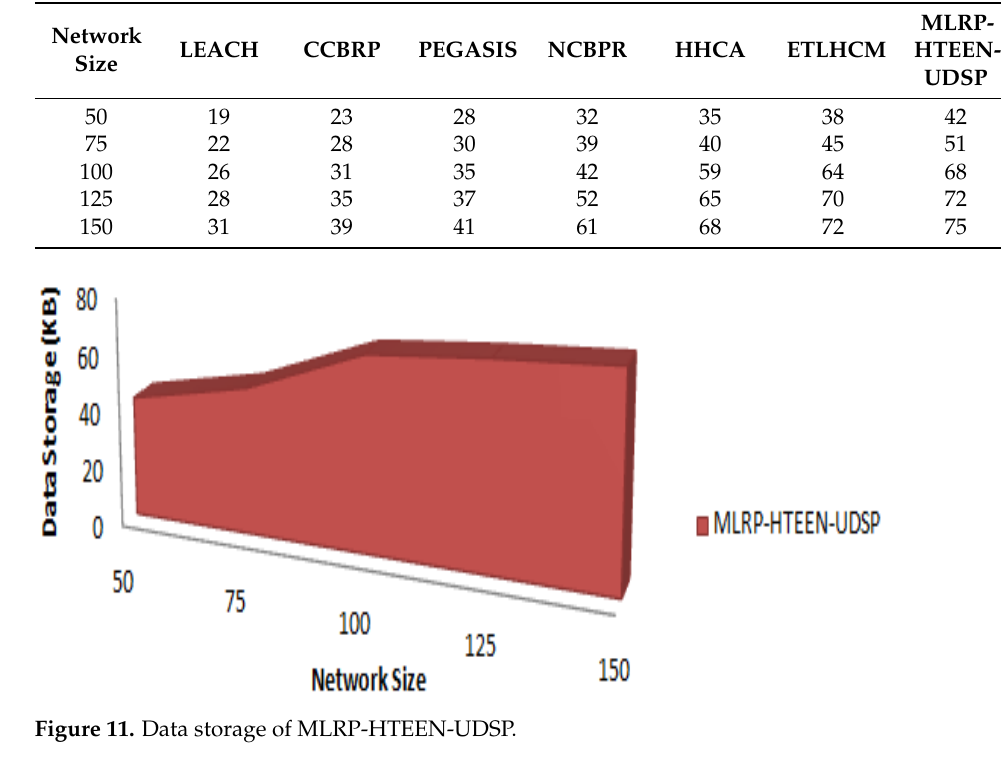
Figure 11. Data storage of MLRP-HTEEN-UDSP.